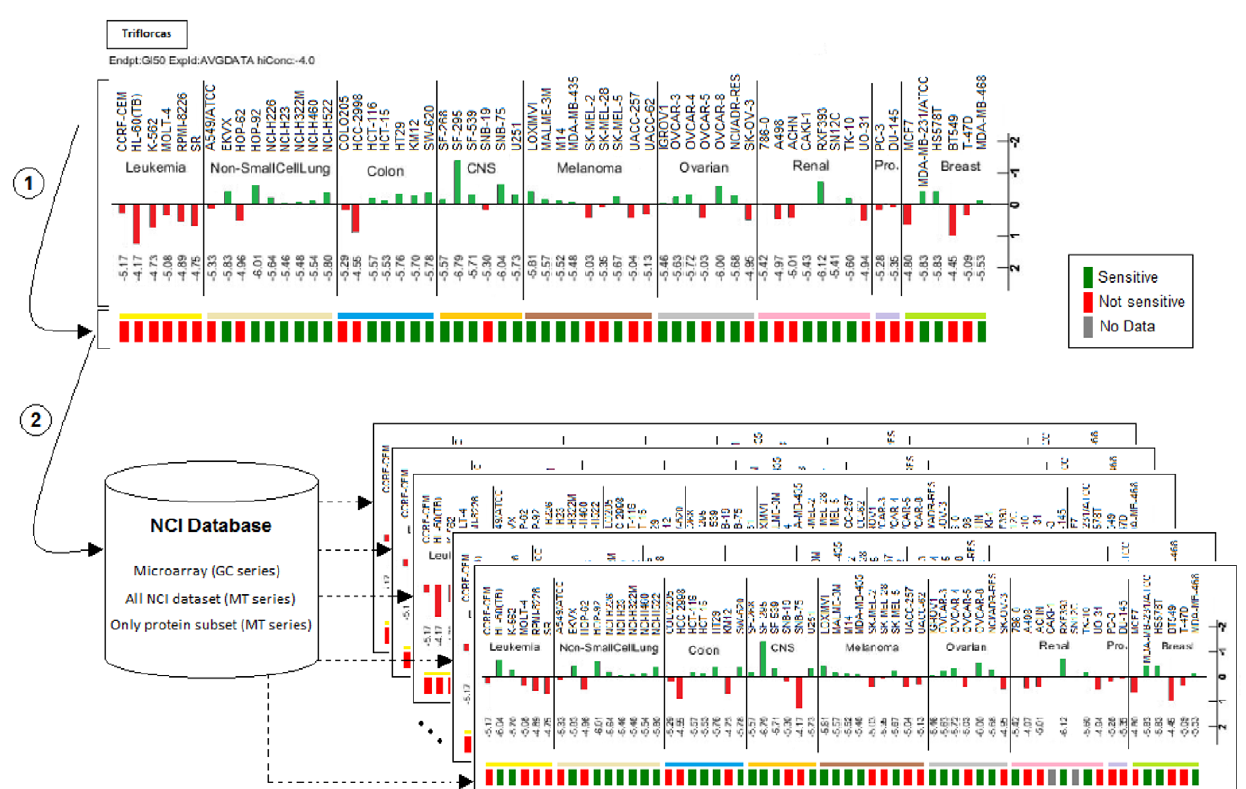
Figure 10. Schematic representation of bioinformatic methodology applied to the NCI Anticancer Drug Screen outcomes. The scheme displays the bioinformatics strategy applied to compare the sensitivity profile of NCI cancer cells with changes in molecular signatures from NCI data resources. 1: Sensitiveness of NCI cell lines to Triflorcas was extracted by using the mean GI 50 into a numeric format and standard scores were visualized using green and red squares to indicate cells responding or not to Triflorcas, respectively. 2: NCI data resources applied to these studies (whole set of 87,545 measured targets) included: ‘‘Microarrays’’, ‘‘all NCI dataset’’, and ‘‘only Protein subset NCI’’ (see Material and Methods). The same color code was applied to indicate positive (green square) or negative (red square) changes of each molecular target analyzed.